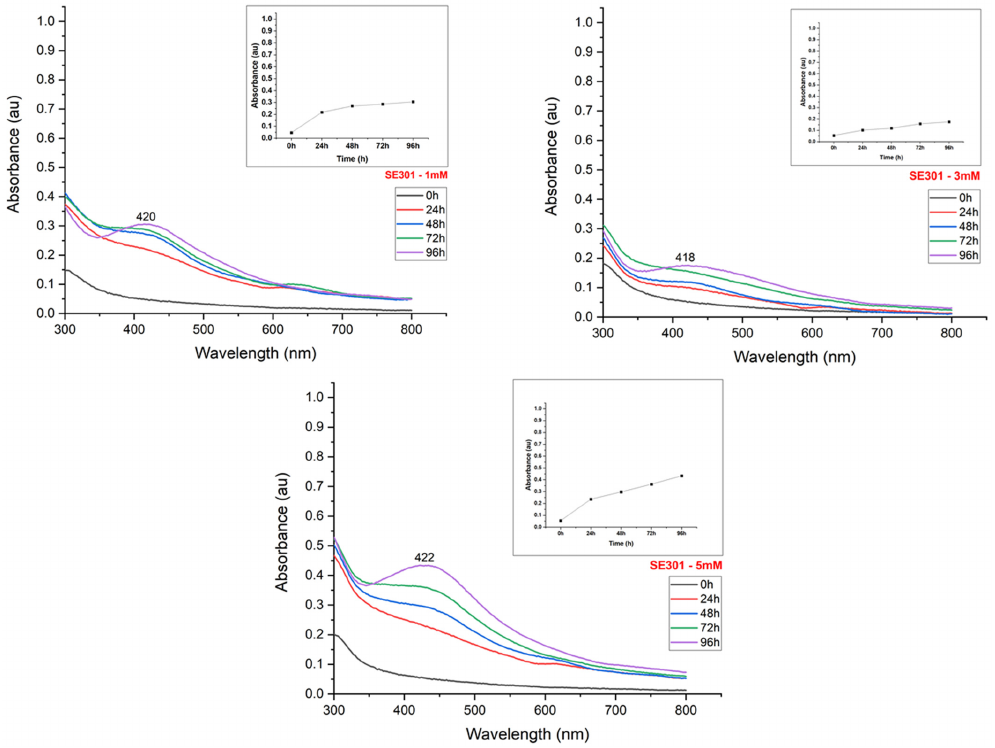
Figure 6. UV-Visible absorption spectrum of the evaluation of the effect of silver nitrate concentration on the synthesis of silver nanoparticles using an extract of the fungus I. fumosorosea (isolate SE301).